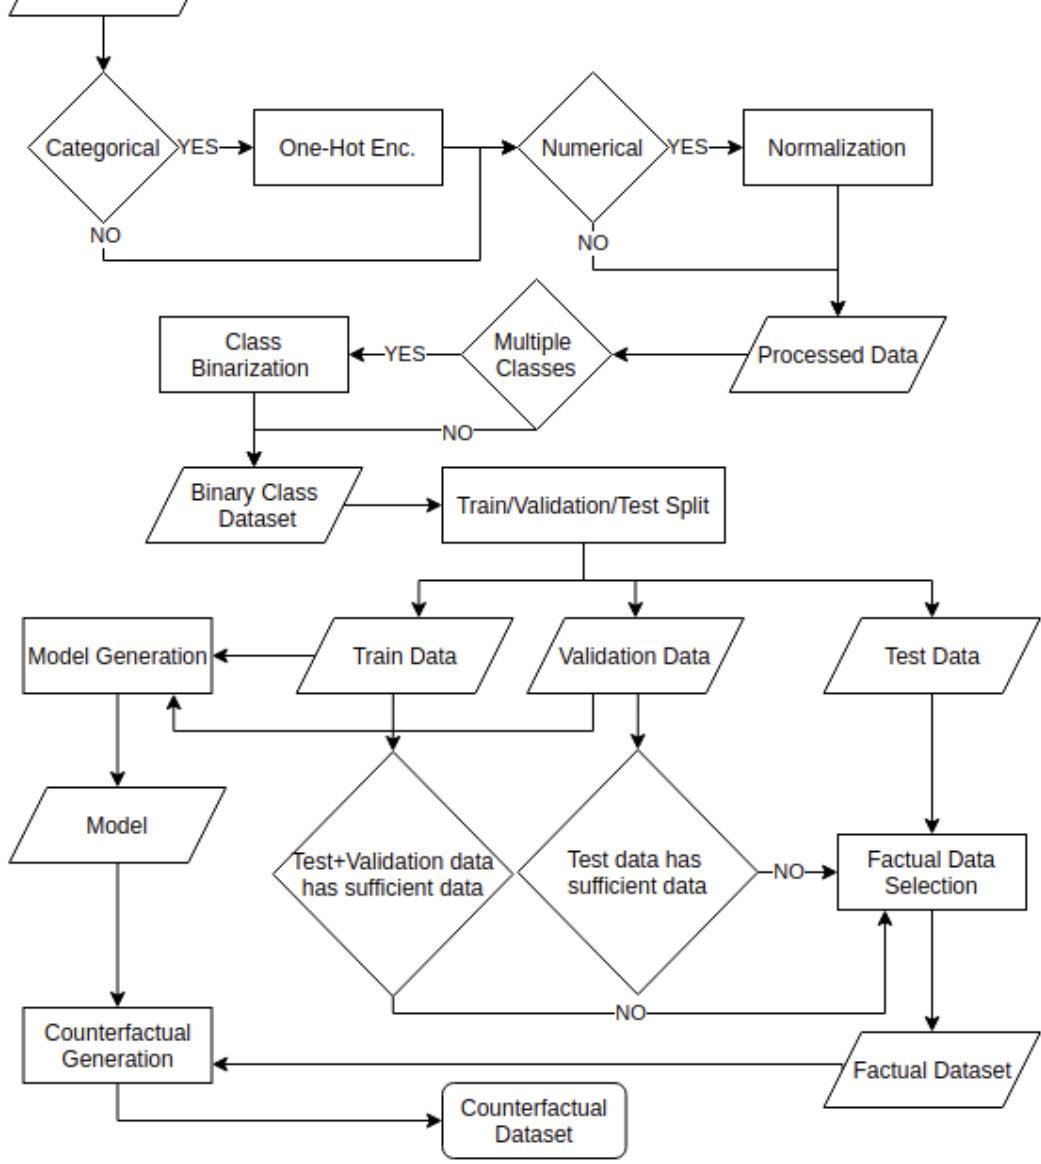
Figure 2. Flowchart detailing the benchmarking process from taking the raw dataset to the counterfactual